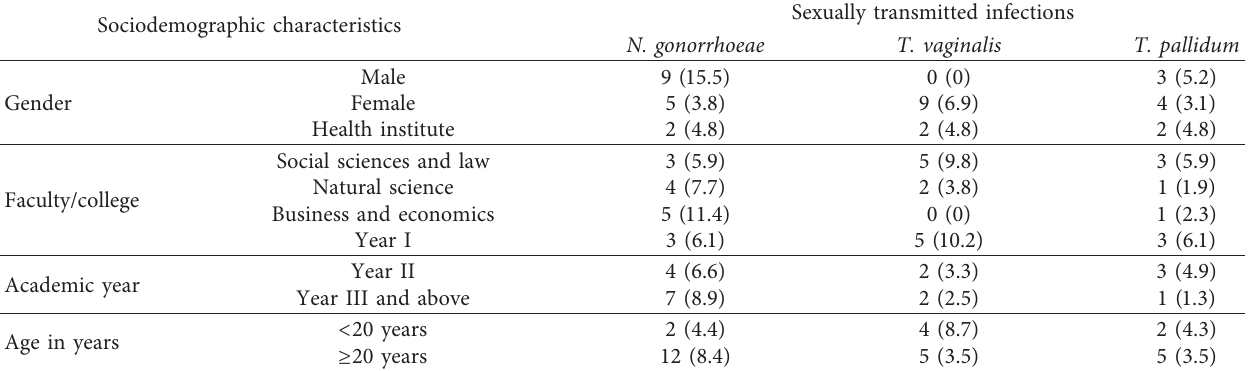
Table 1: Proportion of sexually transmitted infections among Jimma University students ( n � 27). Sociodemographic characteristics